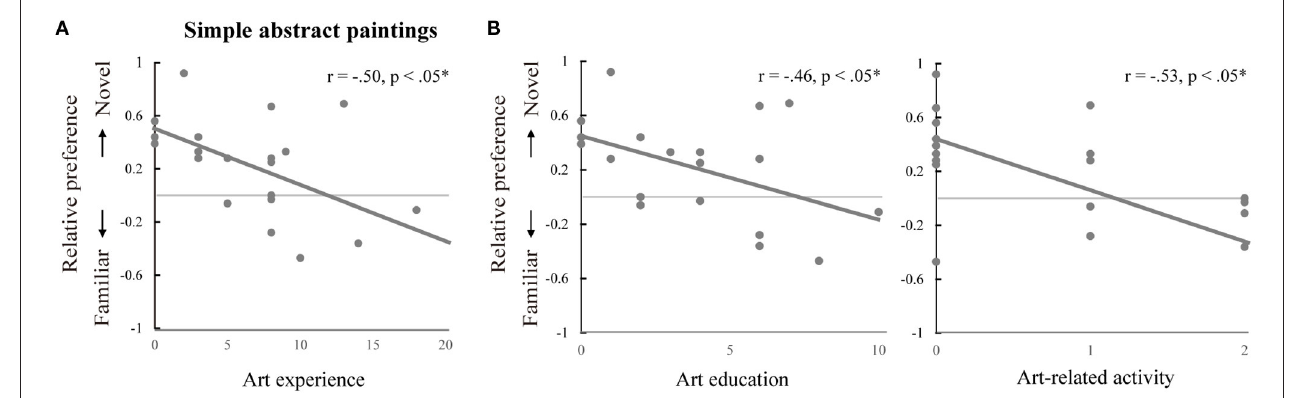
FIGURE 3 | Familiarity-novelty preference and art experience in simple abstract paintings. (A) Correlation between the mean relative preference values and the total art experience scores. (B) Correlations between the mean relative preference values and the two subscale scores of art experience: education (left) and activity (right). * p <